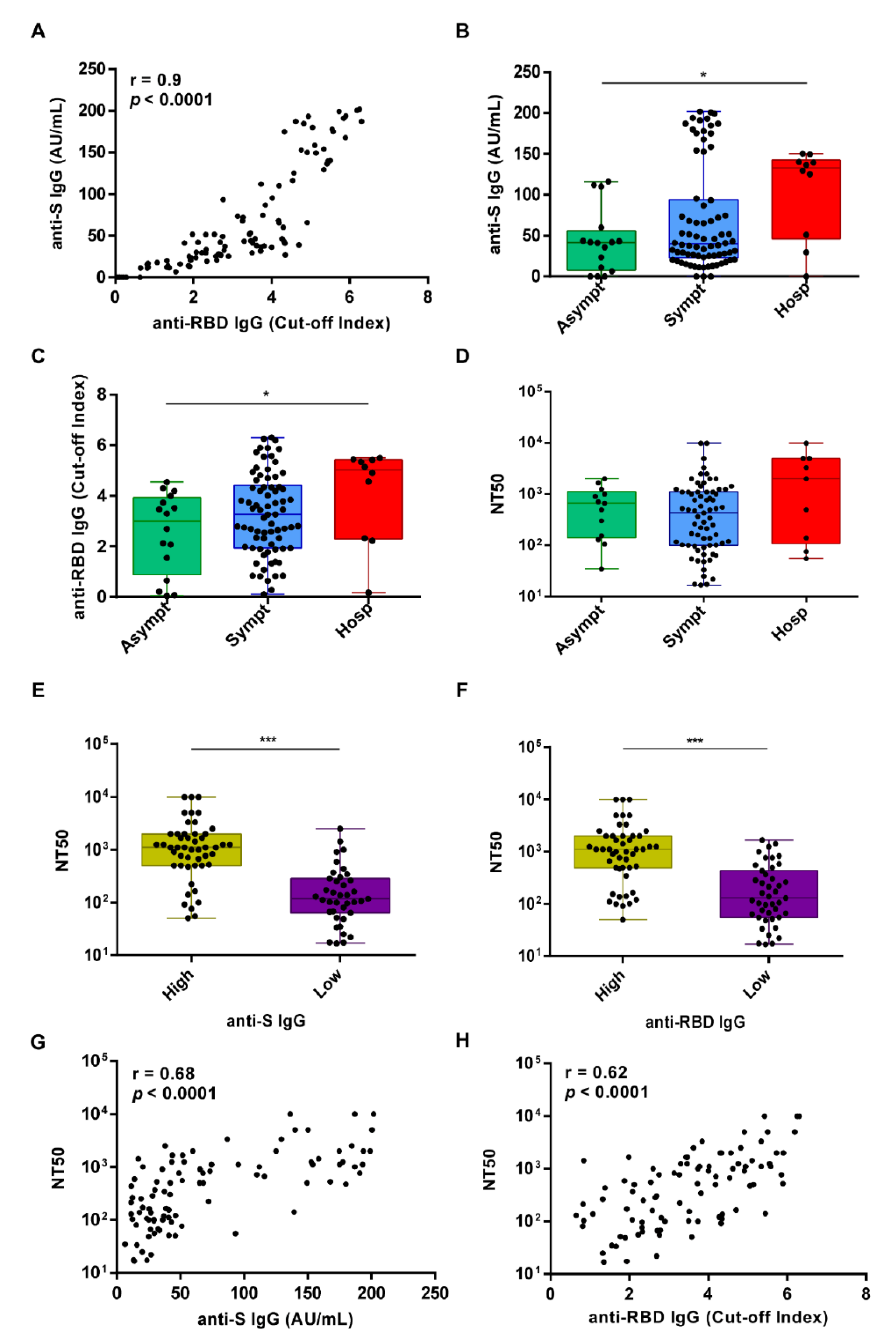
Figure 2. Antibody responses in the study cohort following SARS-CoV-2 infection at 1.5 months (M2) after the first positive PCR test. ( A ) Spearman’s correlation between anti-S IgG AU/mL and anti-RBD IgG cut-off index as assessed by ELISA at M2. ( B – D ) The 100 study subjects were categorized into 3 groups according to disease severity (asymptomatic n = 16, symptomatic n = 74, or hospitalized n = 10) and plotted according to anti-S IgG AU/mL ( B ) or anti-RBD IgG cut-off index ( C ) and the neutralization titer expressed as NT50 ( D ). Solid circles indicate individual values. The p -value among different groups was calculated by Kruskal–Wallis test * p < 0.05. ( E ) Box plot distribution of the neutralizing activity expressed as NT50 in the group of high or low anti-S IgG levels—above and below the median, respectively. ( F ) Box plot distribution of the neutralizing activity expressed as NT50 in the group of high or low anti-RBD IgG levels—above and below the median, respectively. In E and F, the solid circles indicate individual values. p -values were determined by two-sided Mann-Whitney test. *** p < 0.001. ( G ) Spearman correlation between the neutralization titer expressed as NT50 and the anti-S IgG levels. ( H ) Spearman correlation between the neutralization titer expressed as NT50 and the anti-RBD IgG